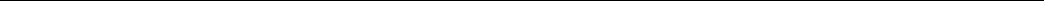
Fig. 3 Loss of TRiC components reduces CSA stability. a Depletion of TCP1 decreases CSA protein abundance. VH10-hTert cells were transfected with the indicated siRNAs and total cell extracts were prepared at the indicated time points after siRNA transfection. Protein levels were determined by western blot analysis of the indicated proteins. H3 is a loading control. Graphs represent the ratio of protein signal intensities over H3 control signal intensities for siTCP1-treated cells relative to that for siLuc-treated control cells, which was set to 100%, at each time point. A repeat of the experiment is shown in Supplementary Figure 2a. b Depletion of TCP1 decreases CSA protein abundance. As in a , except that two different siRNAs against TCP1 were used and that protein levels were determined 72 h after siRNA transfection. A repeat of the experiment is shown in Supplementary Figure 2b. c Depletion of CCT4, CCT5, or CCT7 decreases CSA protein abundance. As in a , except that CCT4, CCT5, or CCT7 siRNAs were used and that protein levels were determined 72 h after siRNA transfection. A repeat of the experiment is shown in Supplementary Figure 2c. d TRiC inhibition decreases CSA protein abundance. VH10- hTert cells were treated with DMSO or an inhibitor against the TRiC subunit TCP1 (TRiCi). Protein levels were determined after 72 h of treatment. e TCP1 or CCT4 loss decreases CSA-GFP protein abundance in the nucleus. TCP1 or CCT4 was depleted from CSA-GFP expressing CS3BE-SV40 cells using the indicated siRNAs. Nuclear and cytoplasmic CSA-GFP levels were analyzed and quanti fi ed by fl uorescence microscopy and ImageJ. GFP signal intensities were normalized to the average nuclear signal in siLuc-treated cells. Data represent mean ± SEM of 190 cells quanti fi ed in two independent experiments. p - Values were derived from an unpaired t -test. Length of scale bar: 10 µ m. Full-size scans of western blots are provided in Supplementary Fig.